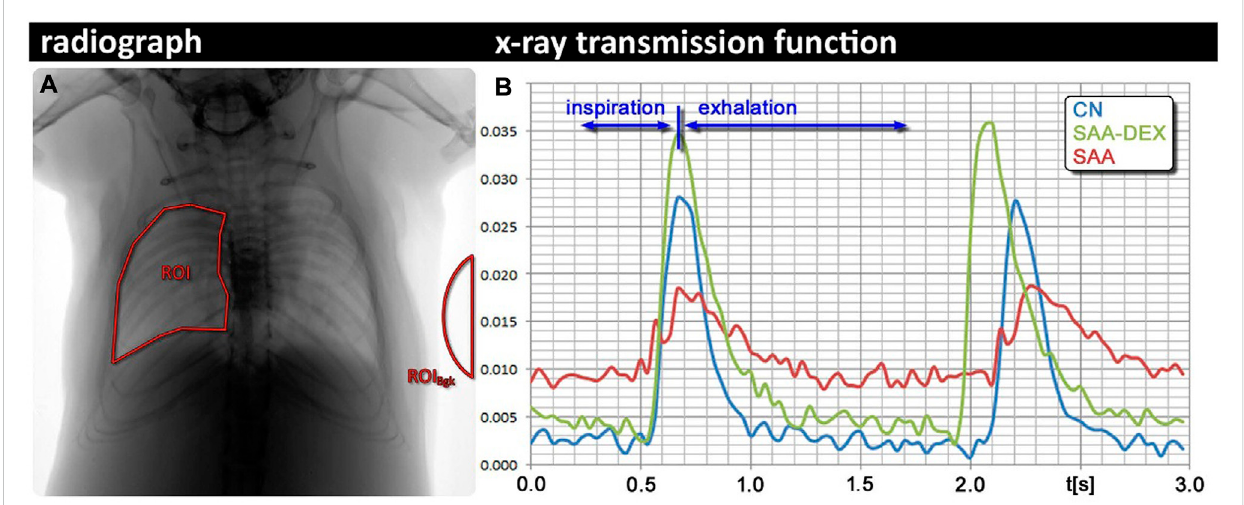
FIGURE 5 X-raylungfunction(XLF)technique (A) Regionoftheinterestofthelunginanexempli fi edradiograph. (B) Comparisonbetweenbreathingcyclesofa healthy control mouse (CN), a mouse with severe accute airway in fl ammation (SAA) 2 days after the last challenge, and a mouse from the same model, treated with dexamethasone before each challenge [reprinted from Dullin et al.